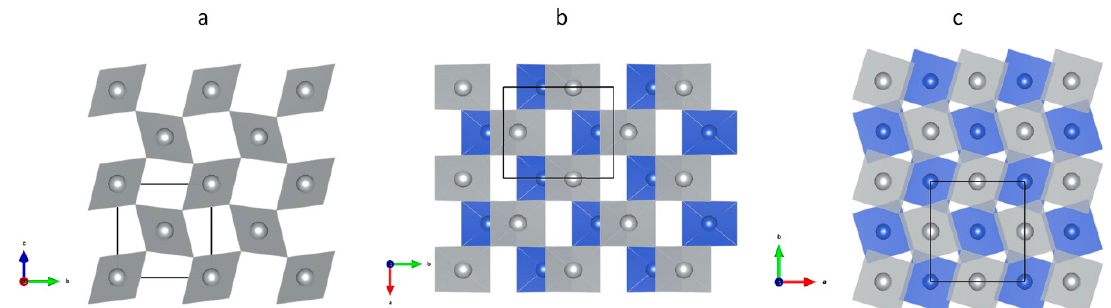
Figure 5. Three stacking patterns realized in the predicted layered AgCl 2 polymorphs with corner-sharing of [AgCl 4 ] plaquettes: AA stacking of rutile-related CuF 2 type ( a ), AB’ stacking ( b ), and AB stacking of fluorite-related AgF 2 type ( c ). The [AgCl 4 ] plaquettes belonging to different layers are distinguished by different color (blue and grey).